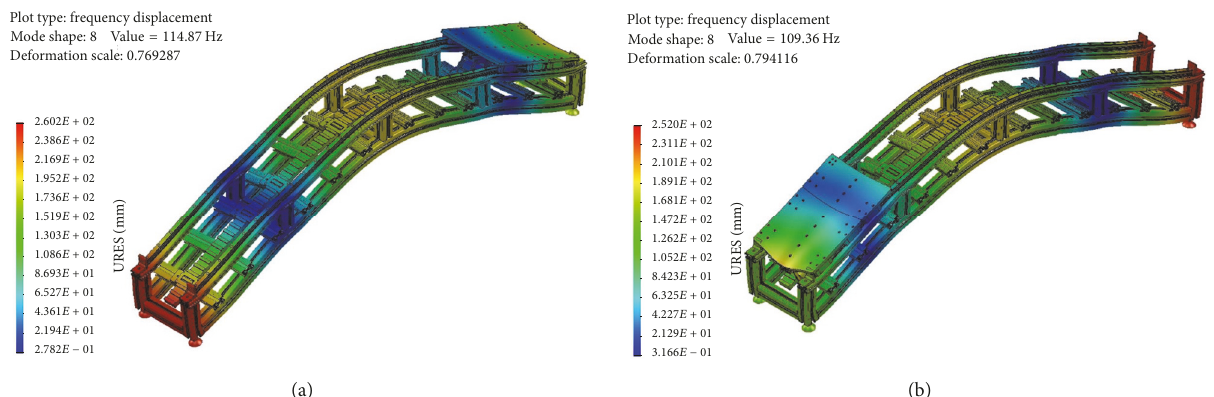
Figure 9: Modal shapes for mode 8, with vertical displacement in both ends: (a) at position P1 ( 𝑓 ≈ 114Hz, deformation scale ≈ 0.769); (b) for position P5 ( 𝑓 ≈ 109Hz, deformation scale ≈